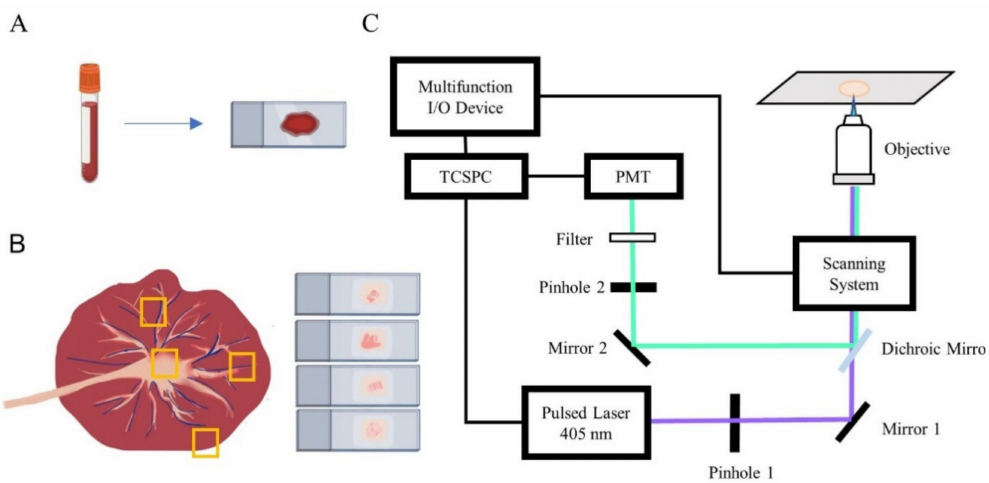
Figure 1. Diagram of sample preparation and equipment. ( A ) Preparation of blood glass smear. ( B ) Schematic diagram of placental sampling at various sites as marked by the yellow boxes. ( C ) FLIM